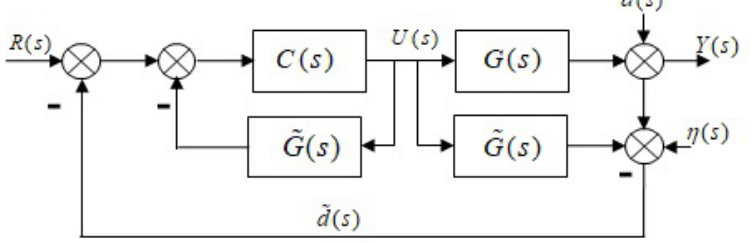
Figure 4. Evolved